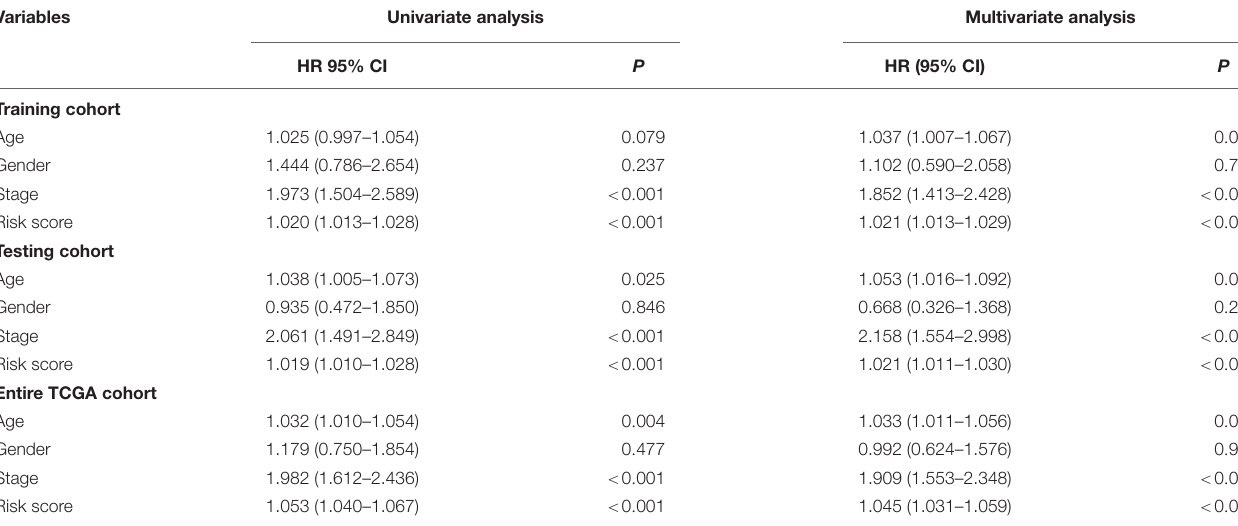
TABLE 4 | Univariate and multivariate Cox regression analyses of the clinical features in each